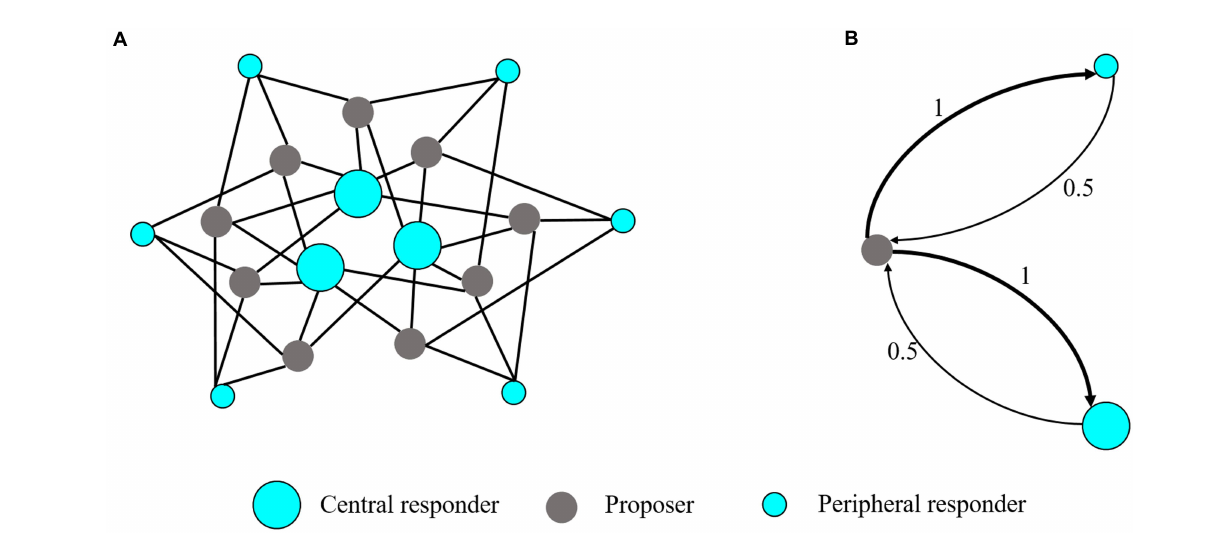
FIGURE 1 Network structure and mean-field approximation of the ultimatum game. (A) The network structure of UG. UG network has three central responders each connected to six proposer neighbors; six peripheral responders, each connected to three proposers and nine proposers each connected to four responders. The payoff of each subject is normalized by his/her number of neighbors. (B) The mean-field approximation of the UG network. The simplified system consists of three (types of) nodes, a proposer, a peripheral responder, and a central responder, representing three typical players in the network. The afferent arrows represent interaction with the neighbors of nodes. The thickness of the arrow and the value on the arrow represents the link weight.